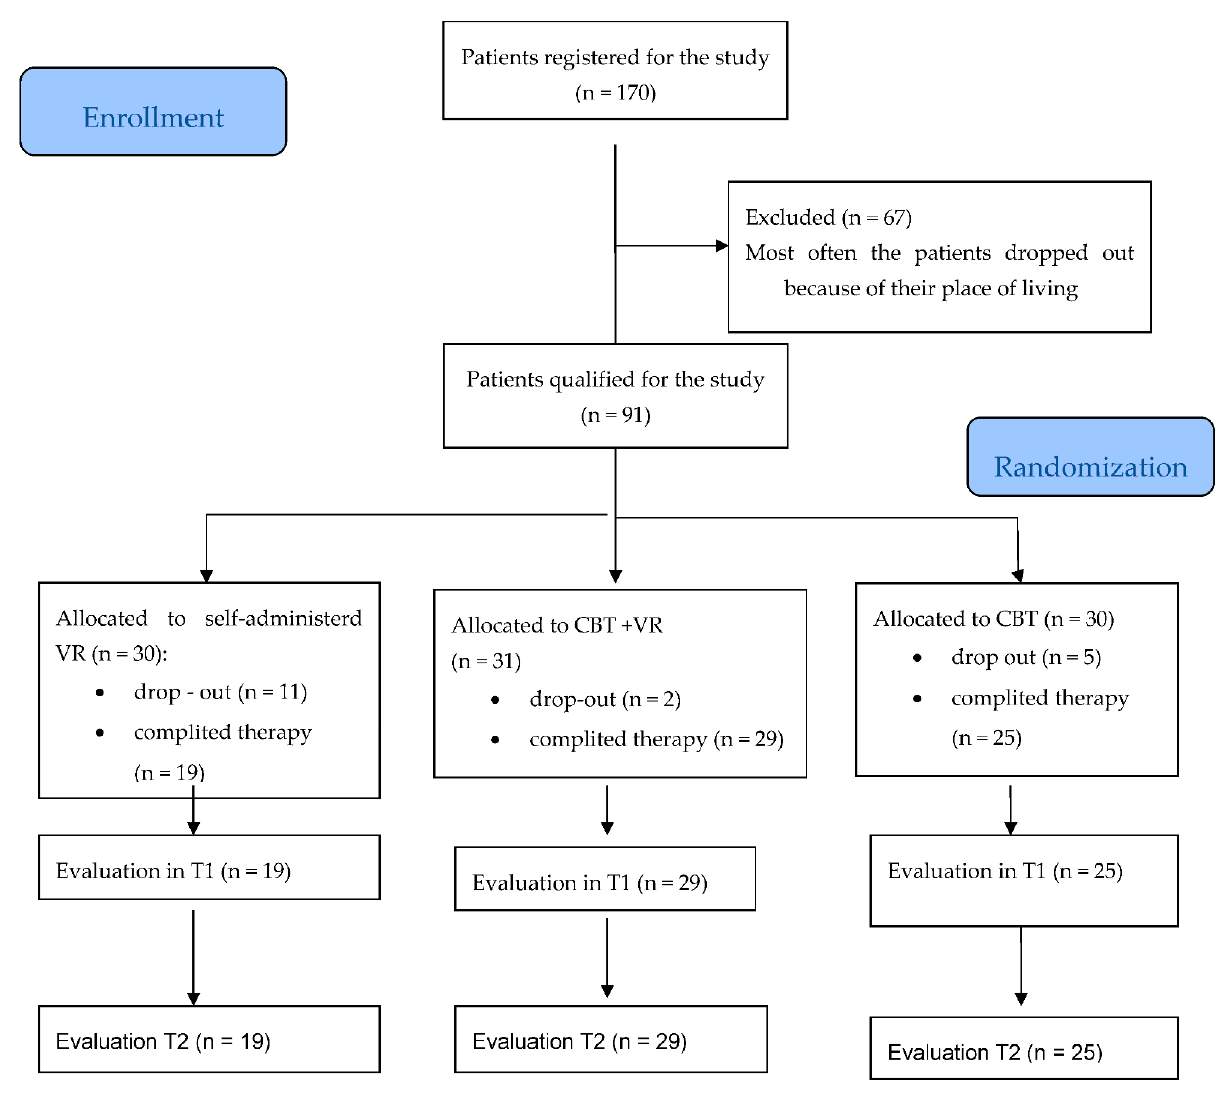
Figure 1. Participant flowchart.